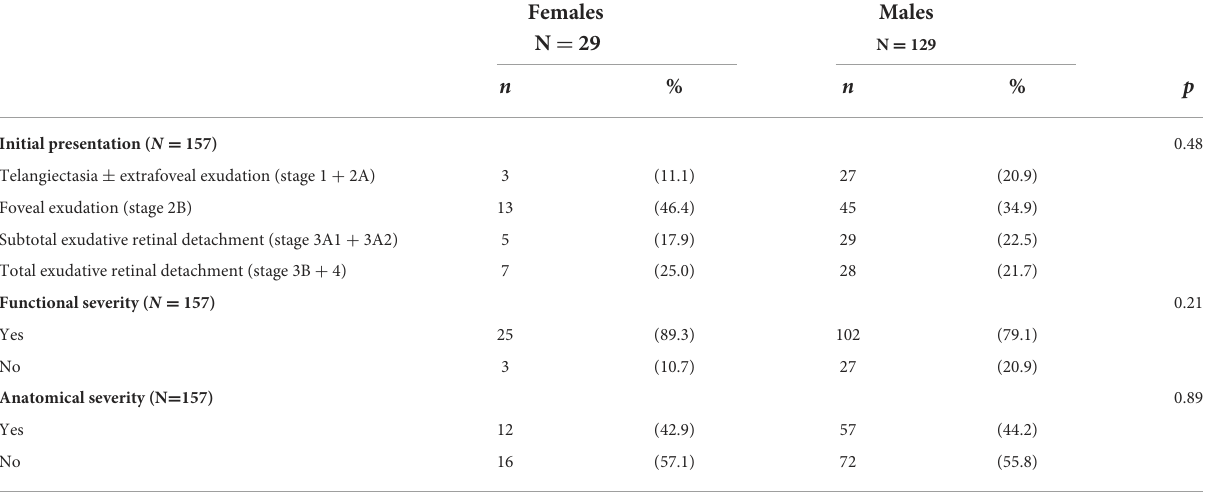
TABLE 2 Comparative analysis of composite criteria at baseline between males and